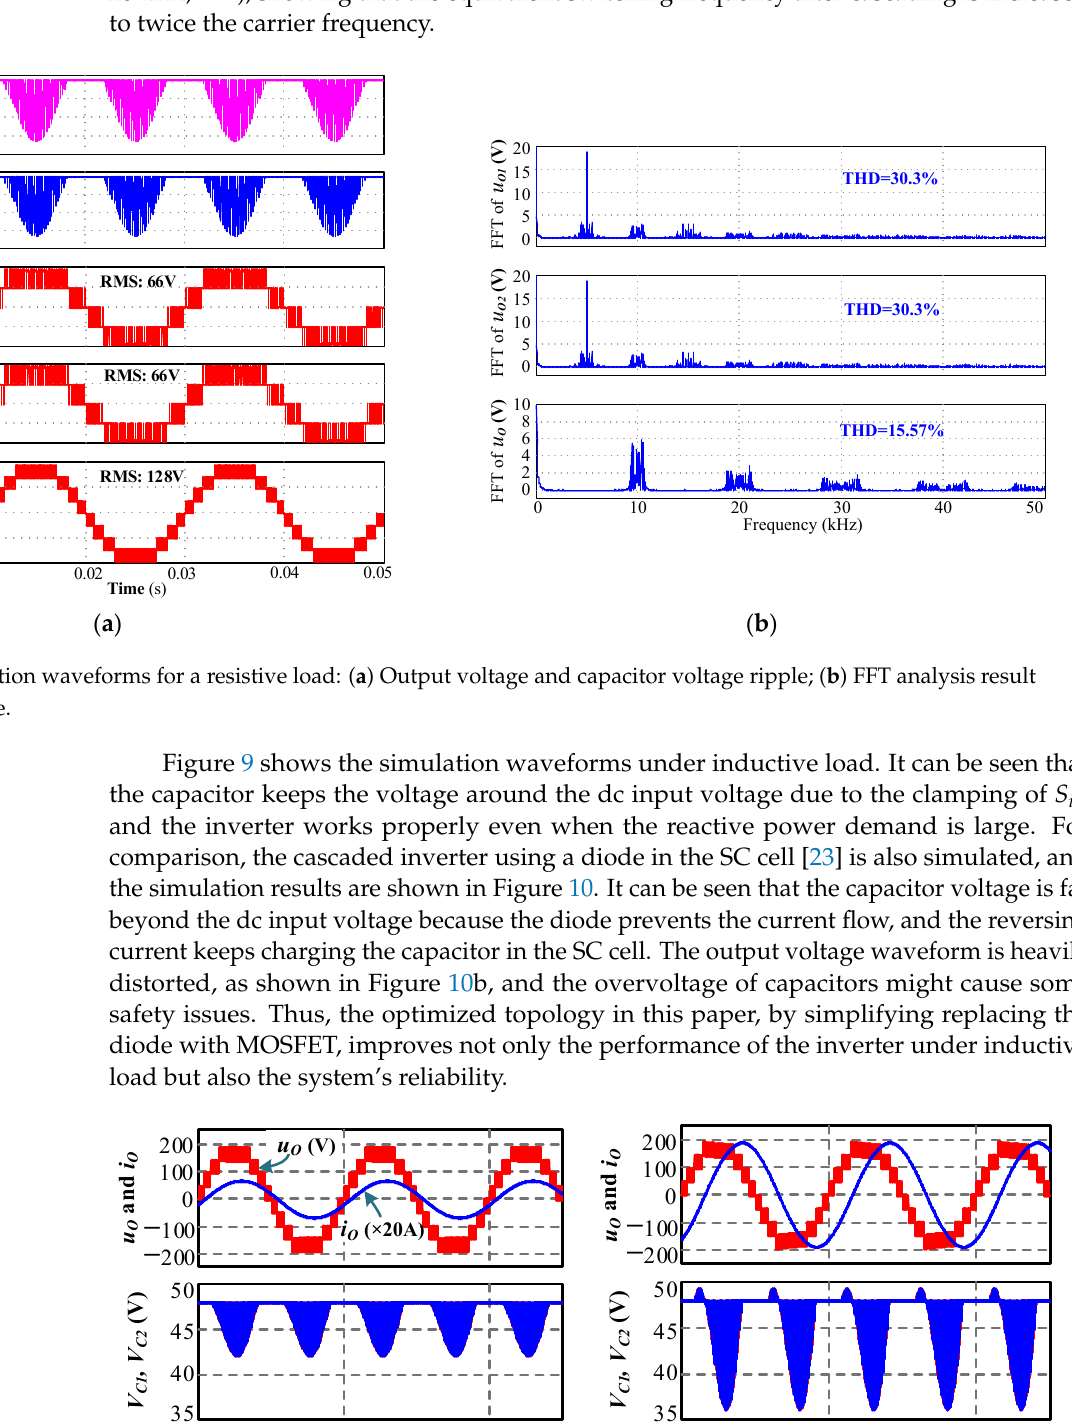
( b ) Figure 10. Simulation waveforms for the original inverter with inductive loads: ( a ) 50 Ω -50 mH; ( b ) 10 Ω -50 mH. In order to compare the reactive power capability of the proposed circuit and the inverter in [23], the capacitor voltage ripple with different inductive loads is depicted in Figure 11. Assuming that the limitation of capacitor voltage ripple is 15% E i , i.e., ∆ V Cmax = 7.2 V, with the inverter in [23], the ripple will reach the limitation when the inductance increases to 120 mH and the power factor of the inverter is about 0.798. With the proposed circuit in this paper, as shown in Figure 11, the voltage ripple will never exceed the limi- tation even with a large inductance.